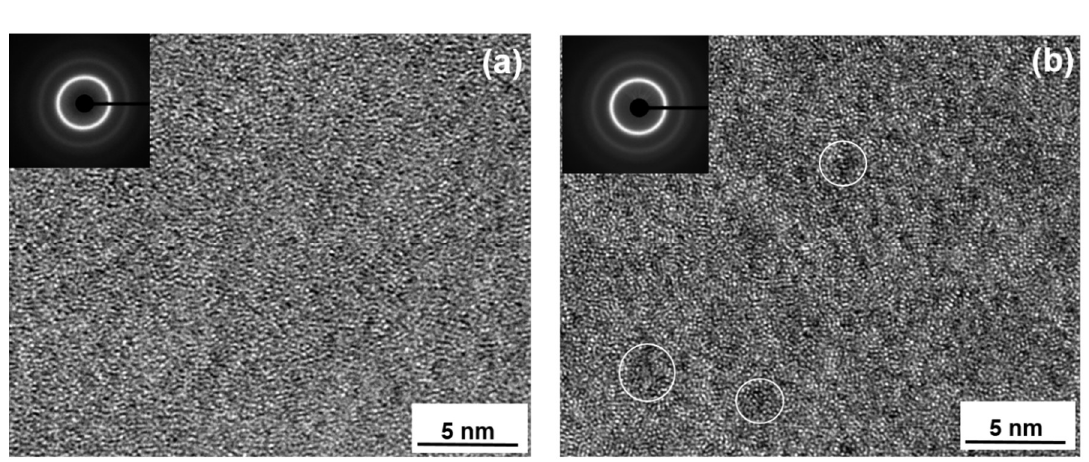
Figure 2. Bright-field HRTEM images of the as-cast ( a ) FeCoBSiNb and ( b ) [FeCoBSiNb] 99.5 Ga 0.5 glasses. The insets show the corresponding fast Fourier transformed (FFT) images. Some features of local ordering / clusters are observed, which are marked by the white circles.